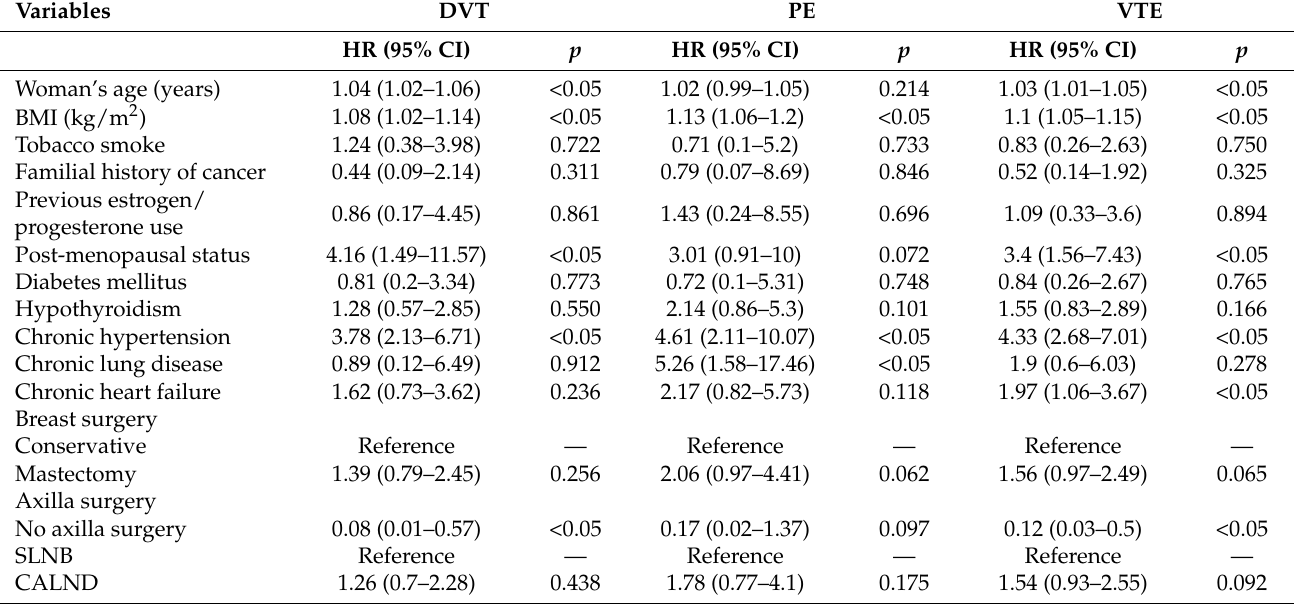
Table 2. Women characteristics and tumor histology considering the whole cohort of women treated with breast surgery. Univariate Cox proportional hazards model analysis evaluating for a new diagnosis of deep vein thrombosis (DVT), pulmonary embolism (PE), or venous thromboembolism (VTE) after breast surgery and possible associated